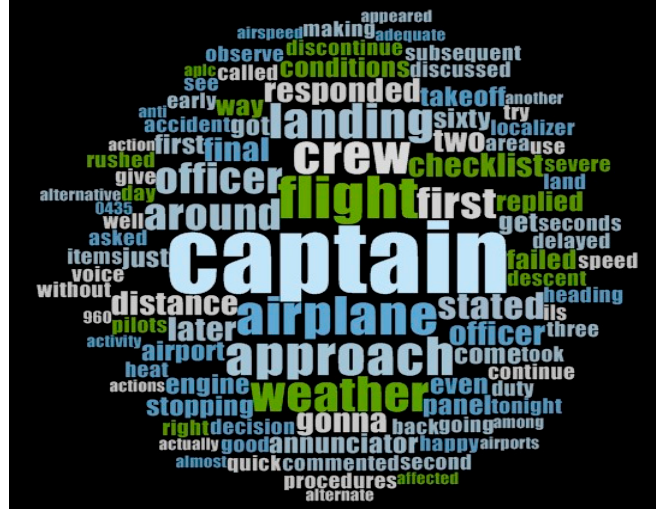
Figure 6. Word frequency tag cloud for Get-There-Itis.